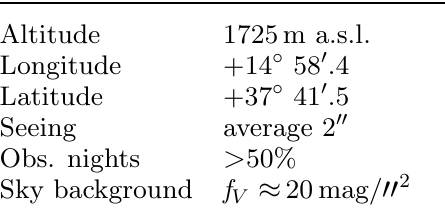
Table 1. The M. G. Fracastoro station